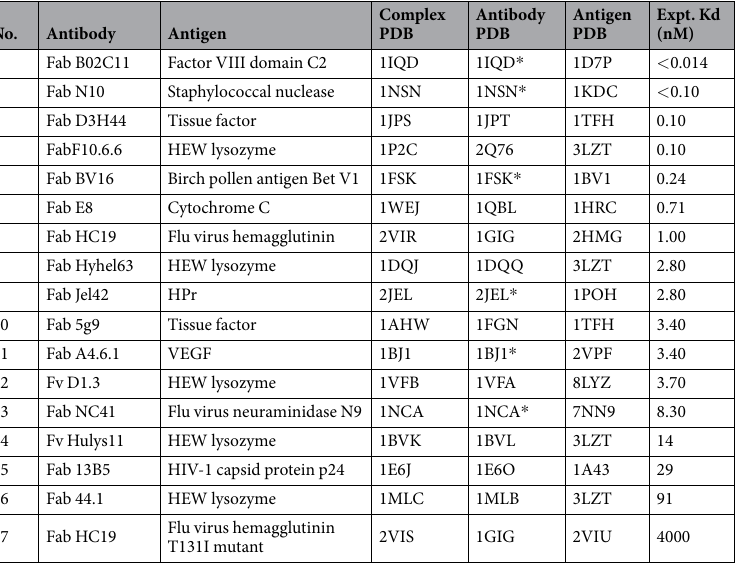
Table 1. Antibody–antigen complexes used for cross-docking. * In these six cases, the only antibody structure available is in the antigen-bound